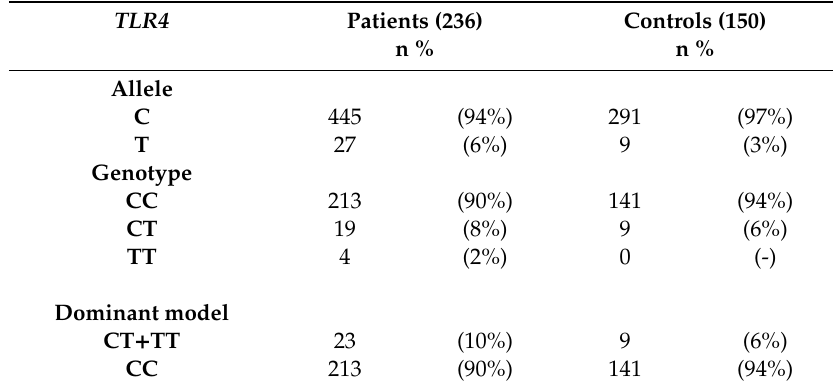
Table1. Alleleandgenotypefrequenciesofthe TLR4